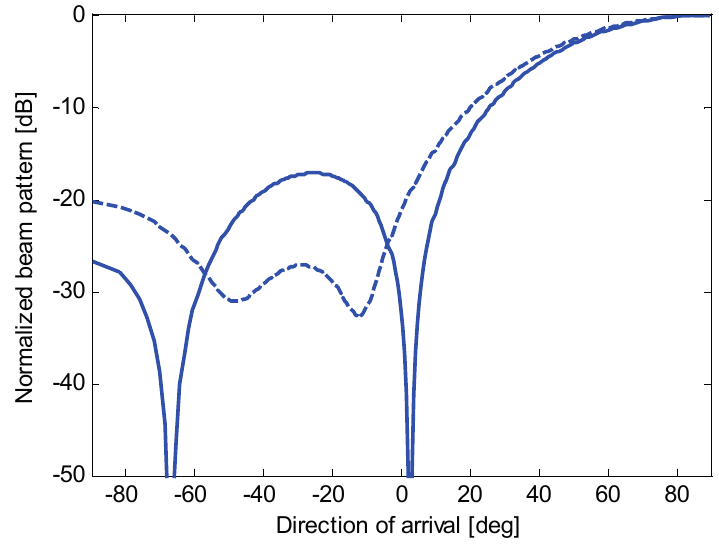
Figure 13. Nominal beam pattern (solid line) and actual beam pattern (dashed line) for beamforming with optimum complex weights applied to an end-fire array of eight microphones.